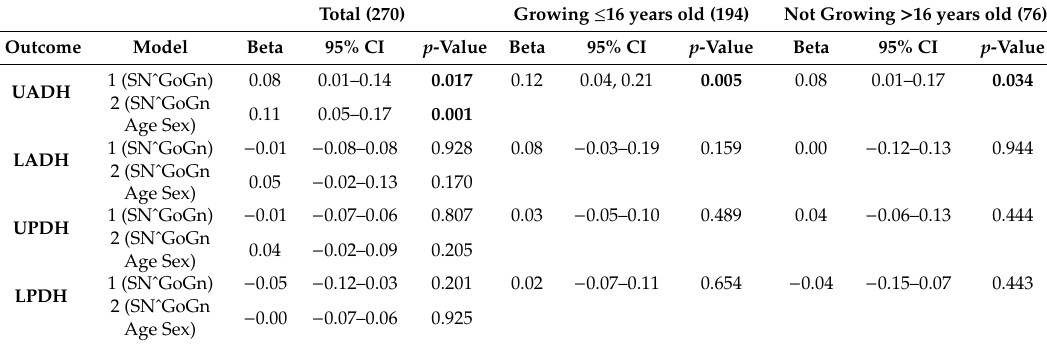
Table 5. Regression analysis between SNˆGoGn and the di ff erent dentoalveolar